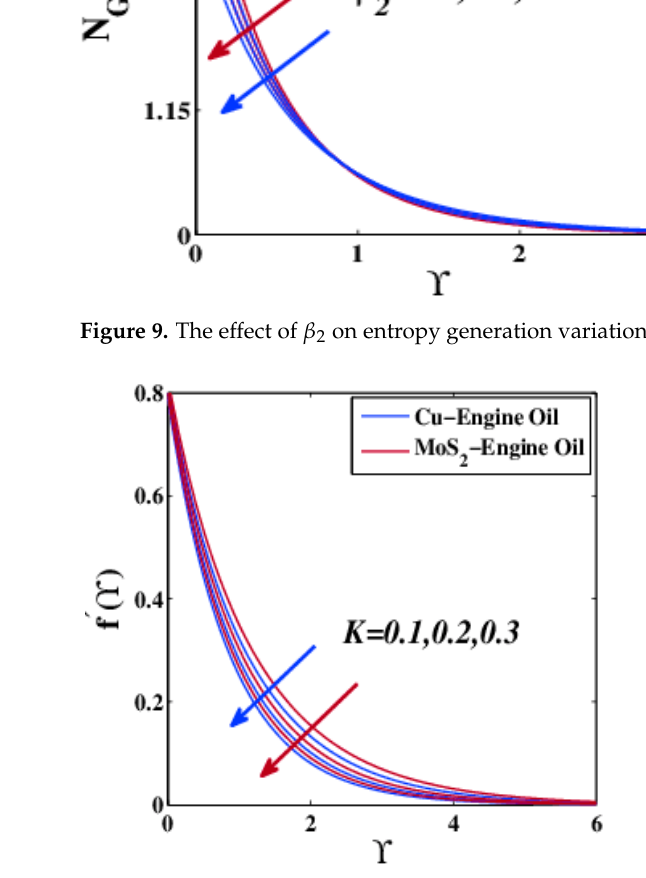
Figure 10. Velocity variation 𝑓 (cid:4593) (𝛶) under the influence of 𝐾 .